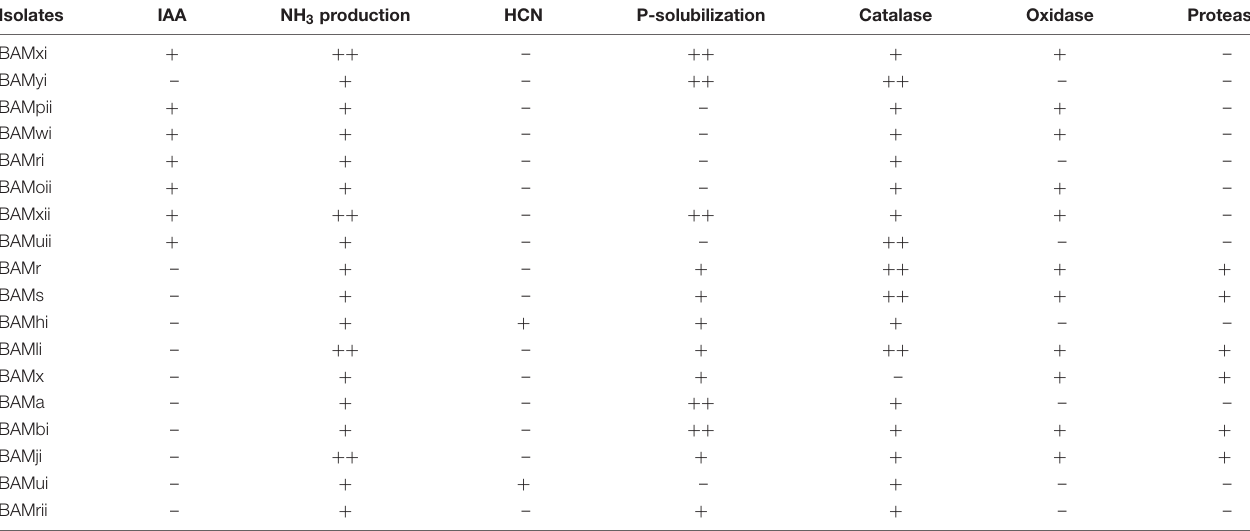
BAM means isolates are from Bambara groundnut rhizosphere, while the letters represent the different isolates. + , means positive; –, means negative; ++ , means very positive.